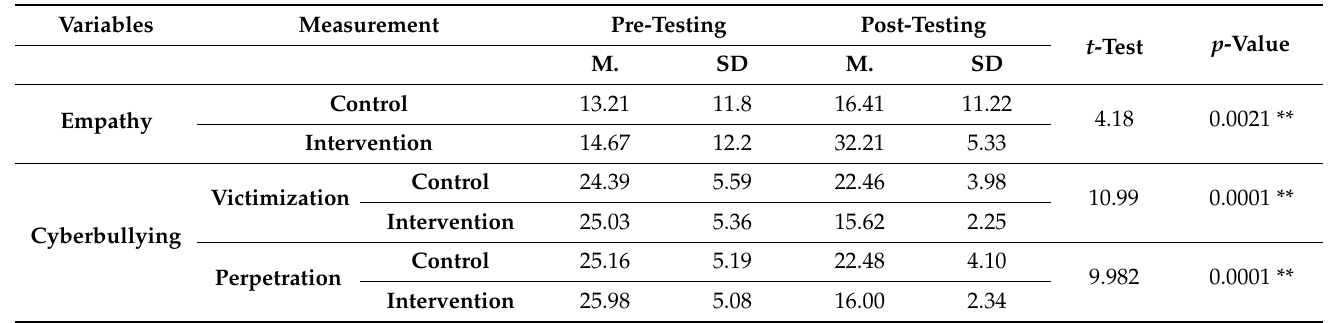
Table 3. Mean scores in the experimental group on empathy and cyberbullying before the intervention and immediately after the intervention (N = 217).